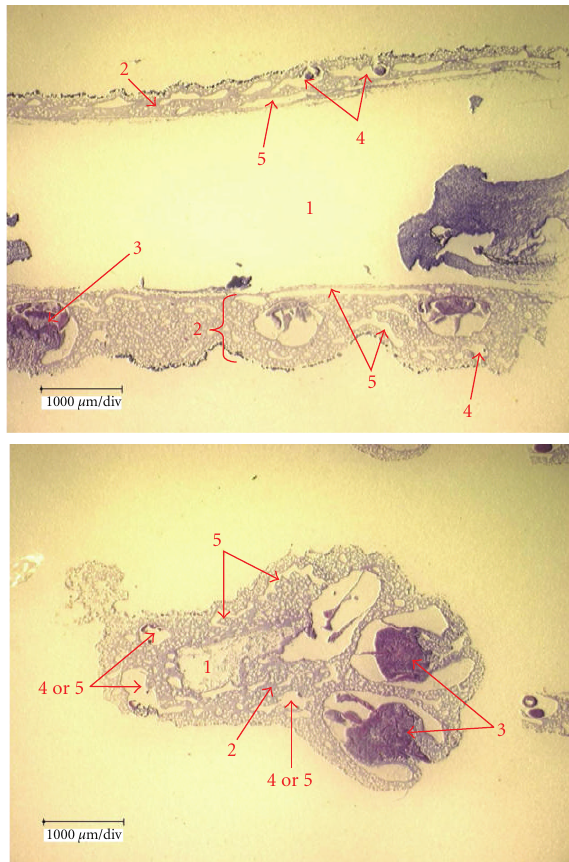
Figure 16: Histological sections of Corallium elatius ; longitudinal section of OCA-Cn20050606-008 (above), and transversal section of OCA-Cn20050620-021 (below). 1: axis, 2: coenenchyme, 3: autozooid, 4: siphonozooid, 5: vascular canals.